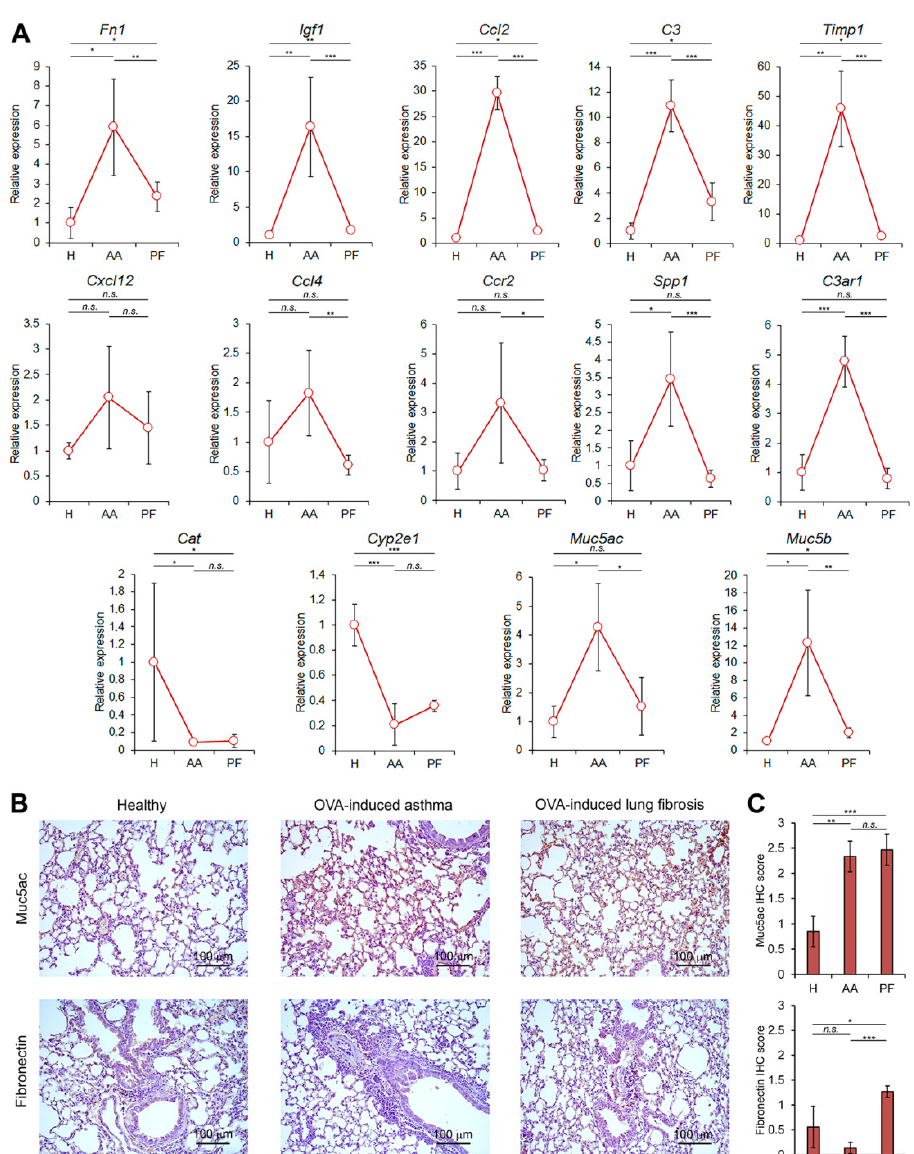
Figure 5. Expression of key genes identified by bioinformatics analysis in the lung tissue of OVA-challenged mice. ( A ) qRT-PCR data for healthy lungs (H), acute asthma (AA, 24 h after the last OVA challenge), and pulmonary fibrosis (PF, 4 weeks after the last OVA challenge). Expression levels were normalized to the expression level of hypoxanthine phosphoribosyltransferase ( HPRT ) (used as the reference gene). Three to five samples from each experimental group were analyzed in triplicate. The data are shown as mean ± standard deviation. The statistical analysis was performed using the two-tailed unpaired t -test; * p ≤ 0.05, ** p ≤ 0.01, *** p ≤ 0.001, n.s., not significant. ( B ) Representative immunohistochemical images of lung sections of healthy and OVA-challenged mice 24 h (OVA-induced asthma) and 4 weeks (OVA-induced lung fibrosis) after induction stained with anti-Fibronectin and anti-Muc5ac primary antibodies. Original magnification × 200. ( C ) The intensity of immunohistochemical staining of lung sections was assessed by a semi-quantitative method, where 0 is no expression, 1 is low expression, 2 is moderate expression, and 3 is high expression. The number of samples studied was three for each experimental group. The statistical analysis was performed using the two-tailed unpaired t -test; * p ≤ 0.05, ** p ≤ 0.01, *** p ≤ 0.001, n.s., not